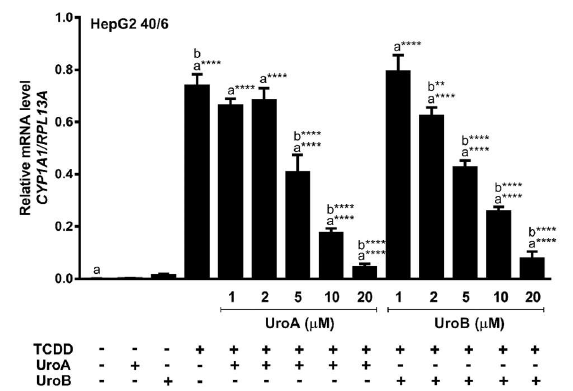
Figure 3. Dose-response assessment of AHR antagonism by UroA and UroB. HepG2 (40/6) reporter cells were treated for 4 h with 10 nM TCDD and indicated doses of ( A ) UroA and ( B ) UroB; ( C and D ) Hepa1.1 cells were co-treated with 2 nM TCDD and increasing concentrations of UroA or UroB. Cells were lysed, and luciferase activity was measured. Data are presented as mean +/−S.E.M., n = 3; significance was determined by one-way ANOVA, p -value ≤ 0.01 (**), p -value ≤ 0.001 (***) or p -value ≤ 0.0001 (****).